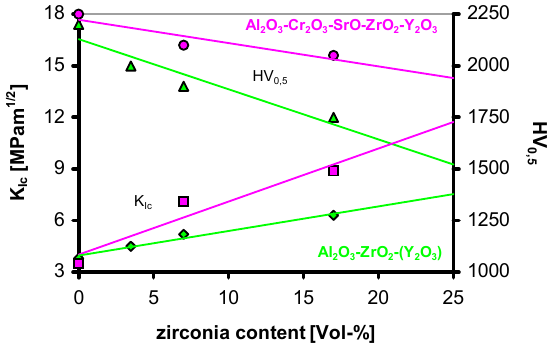
Figure 29. Fracture toughness and hardness in the system Al 2 O 3 -Cr 2 O 3 -ZrO 2 -Y 2 O 3 -SrO.